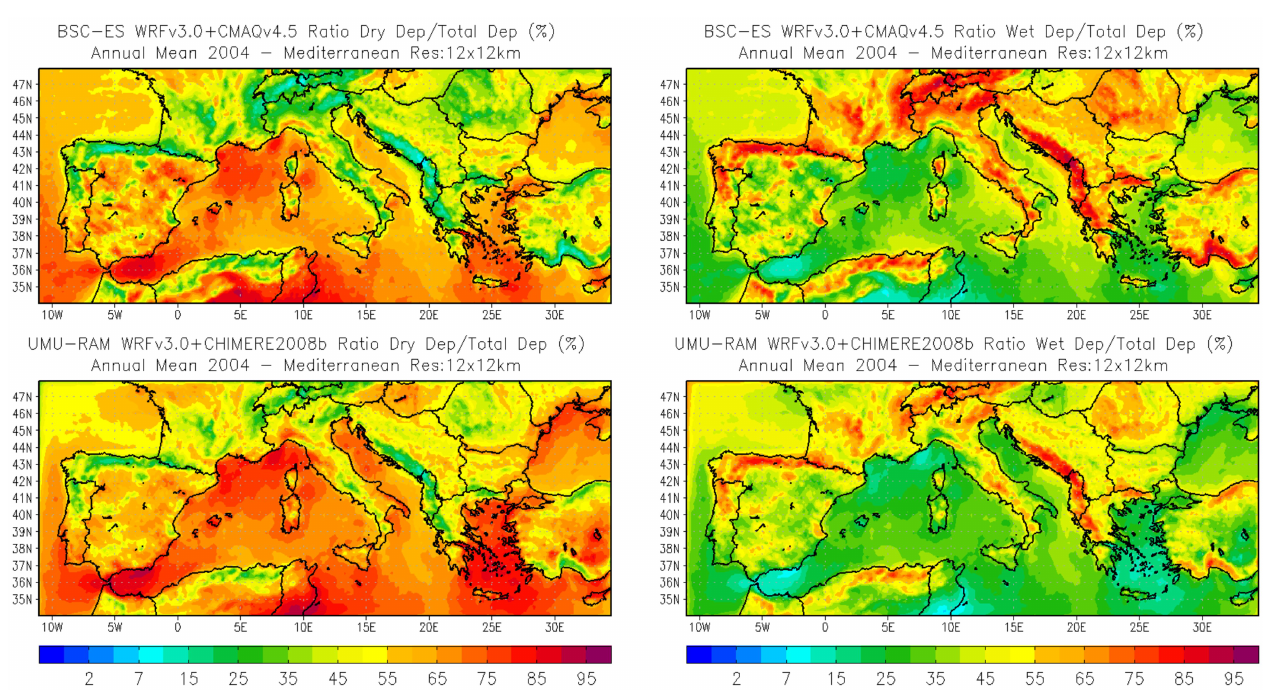
Fig. 7. (Left) ratio dry deposition/total deposition (%) for WRF + CMAQ (top) and WRF + CHIMERE (bottom); (right) ratio wet deposi- Fig. 7. (Left) Ratio Dry Deposition/Total Deposition (%) for WRF+CMAQ (top) and WRF+CHIMERE tion/total deposition (%) for WRF + CMAQ (top) and WRF + CHIMERE (bottom). (bottom); anti-correlation of deposition with SSA levels is − 0.80